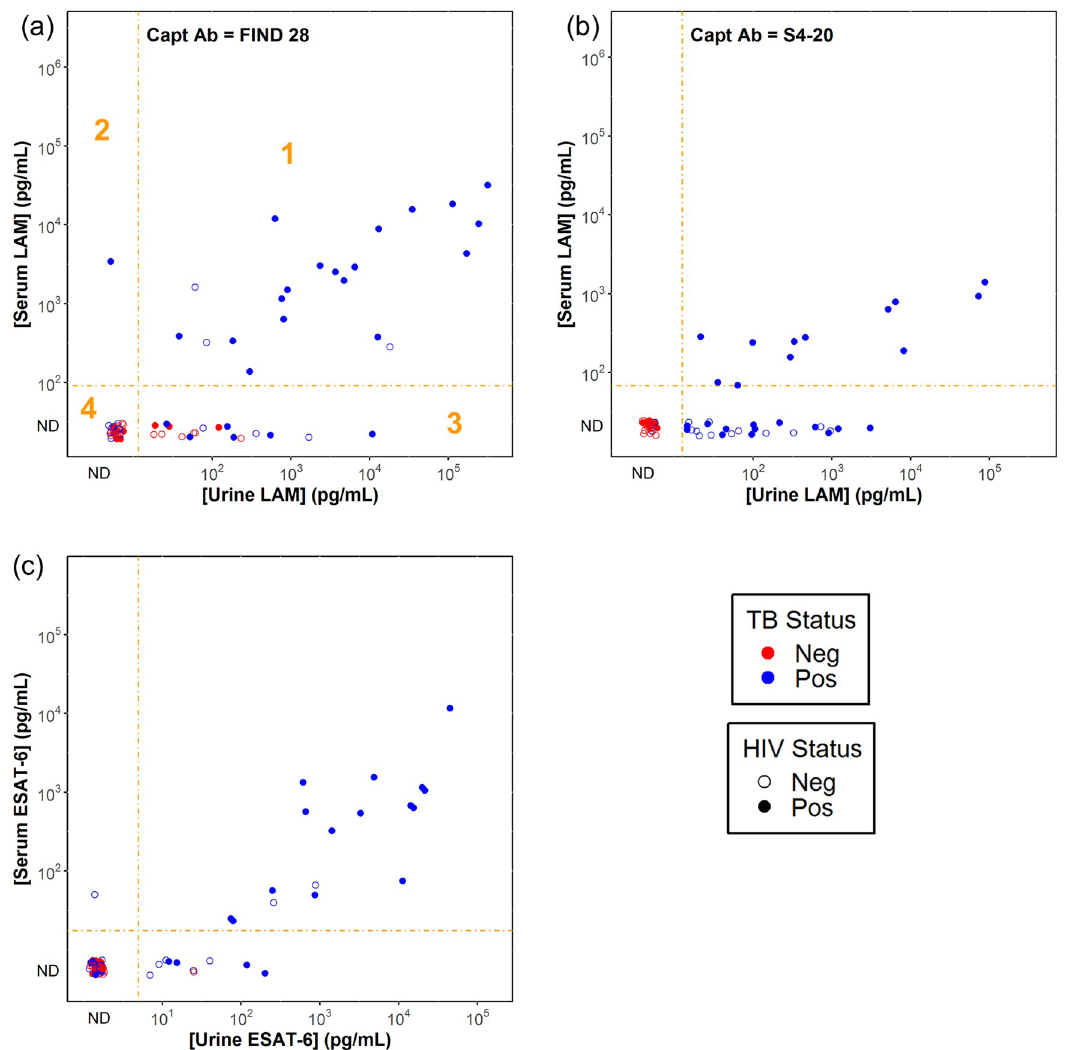
Fig 3. Correlation of LAM and ESAT-6 concentrations in urine and serum. The plots show the results for LAM measurements using the FIND 28 (panel a) and S4-20 (panel b) capture antibodies, and the results for the ESAT-6 assay (panel c). Concentrations in serum are corrected for the additional 4-fold dilution of serum samples relative to urine samples. The dashed orange lines show the dilution-corrected detection limits for the assays. Data points with signals below the detection thresholds (categorized as “ND” or not detectable) are shown for completeness, but do not have assigned concentrations. As indicated with the orange numbering in panel a, the plots can be divided into four regions: (1) concentrations measurable in serum and urine; (2) concentrations only measurable in serum; (3) concentrations only measurable in urine and (4) concentrations not measurable in either matrix. Percentages of categorical agreement are shown in S4 Table. Data points are colored based on TB status and filled based on HIV status as indicated in the